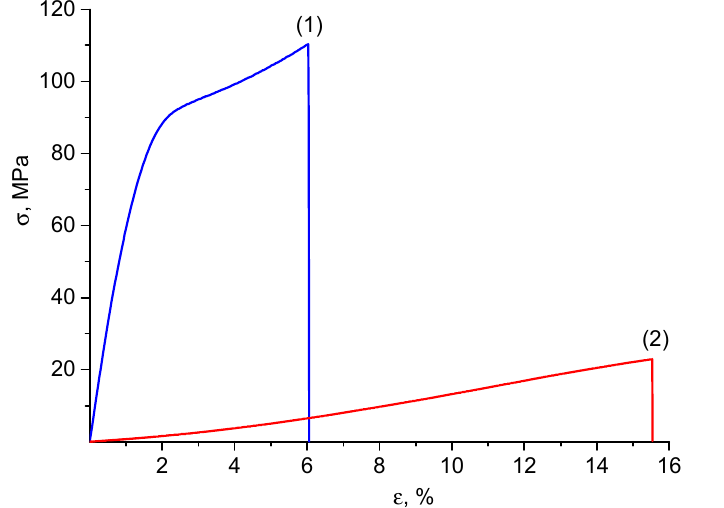
Figure 4. Stress–strain curves of the CS(80)-BC(20)-CeONP(8) film in dry (1) and swollen (2) states.